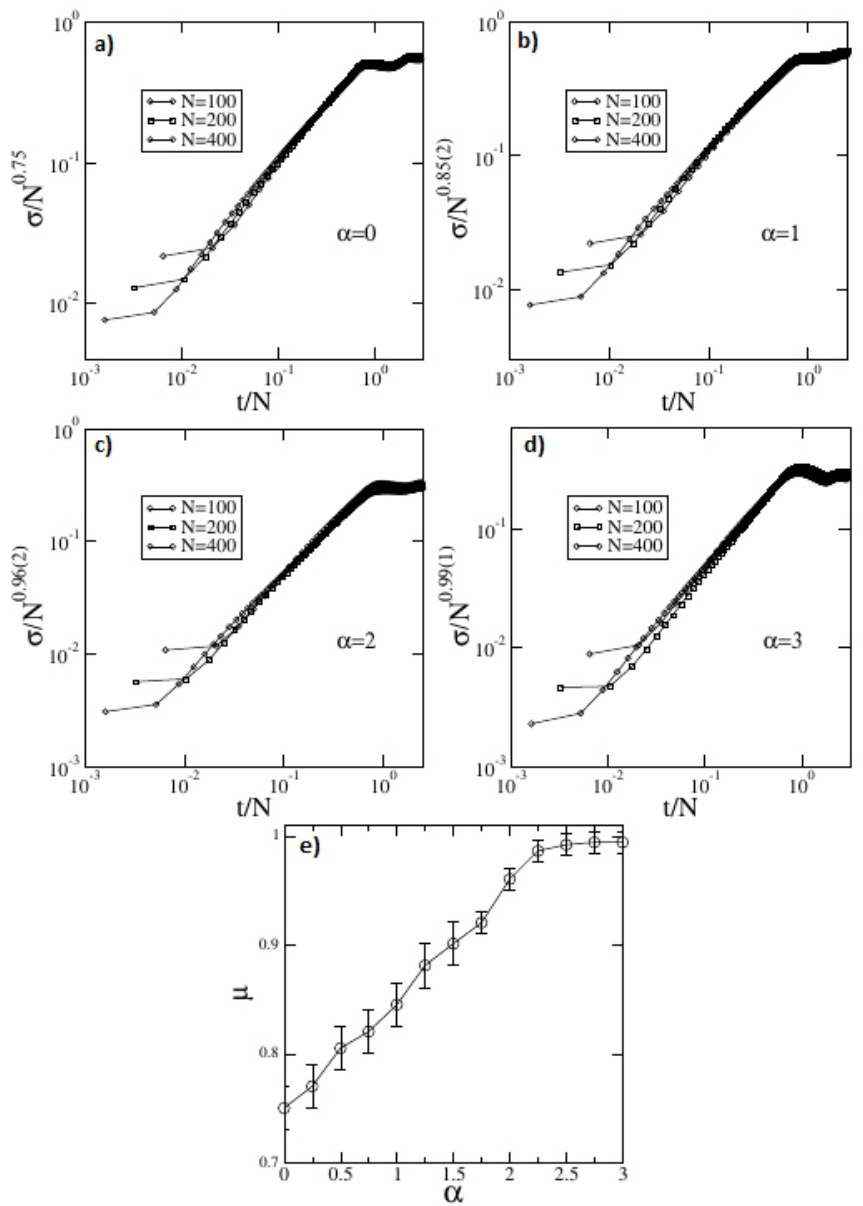
Figure 3 - (a-d) Rescaled energy spread σ (t)/N μ versus rescaled time t/N for α = (a) 0 , (b) 1 , (c) 2 and (d) 3 . The initial condition used was x n,m (t = 0) = m + Δδ n,n v n,m x (t = 0) = v n,m y (t = 0) = 0 (here we used Δ = 0.5 ). The data collapse for α = 3 suggests occurrence of ballistic dynamics ( σ (t) ∝ t 1 ). For α < 2 , our calculations point to a superdifusive dynamics with exponent ς ∝ t μ with μ < 1 . In (e) we plot the evolution of the exponent μ as the correlation becomes stronger.